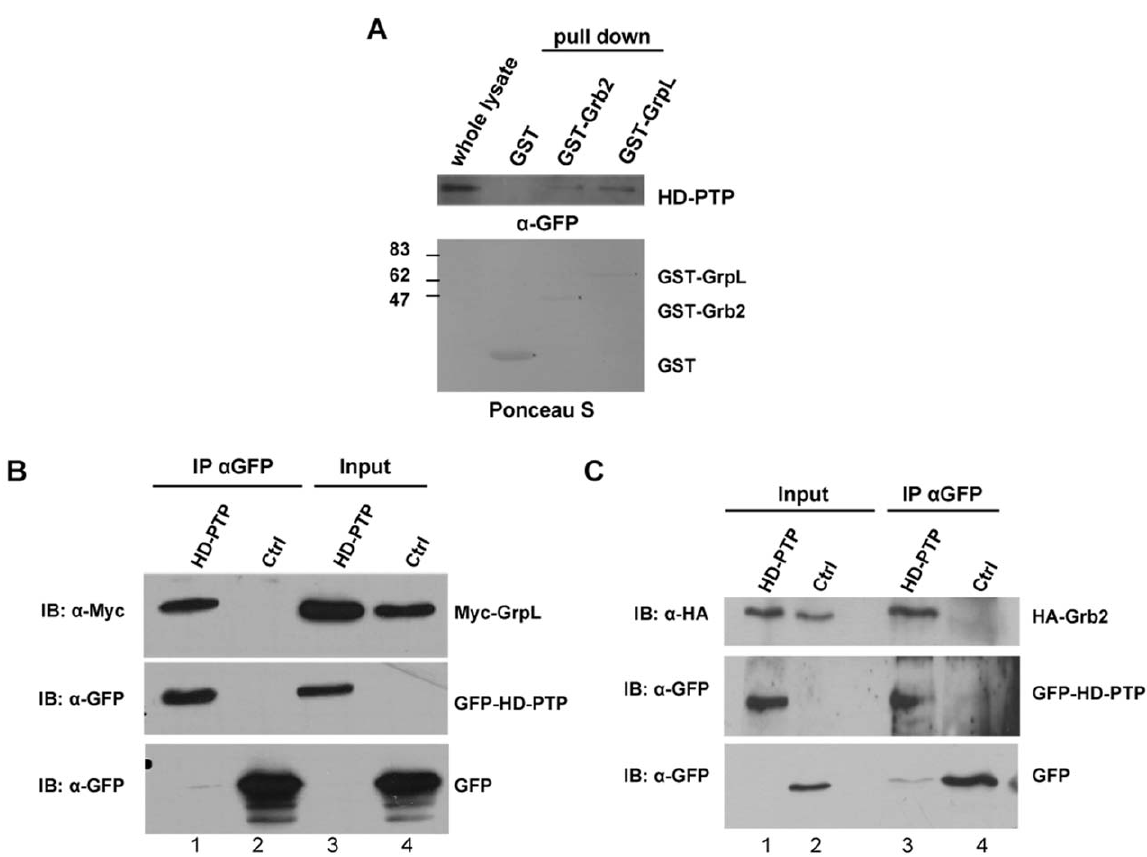
Figure 2. Analysis of HD-PTP interaction with Grb2 and GrpL by GST pull-down and immunoprecipitation. (A) HEK293T cells were transfected with EGFP-HD-PTP and cell lysates were incubated with GST, GST-Grb2, or GST-GrpL. After extensive washing, the presence of bound HD- PTP was analyzed by Western blot with anti-GFP antibodies. The input represents 20% of the lysate used in the pull-down assay. GST fusion proteins were visualized by Ponceau S staining. (B and C) HEK293T cells cotransfected with EGFP-HD-PTP or EGFP-c2 vector alone and either Myc-GrpL (B) or HA-Grb2 (C) were lysed and subjected to co-immunoprecipitation with anti-GFP antibodies. The co-immunoprecipitated proteins and aliquots of whole cell lysates were analyzed by Western blot with anti-Myc or anti-HA antibodies, respectively. The input represents 14% of the lysates used in co-immunoprecipitation. (Fig. 2C) coprecipitated with EGFP-HD-PTP. No interaction was detected when the empty vector pEGFP-c2 was cotransfected with either HA-Grb2 or Myc-GrpL. The faint EGFP band in the HD-